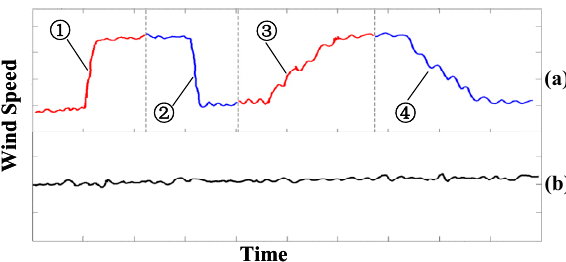
Figure 1. Diagram of the commons changes in wind speed: ( a ) Large fluctuation; ( b ) Small fluctuation.